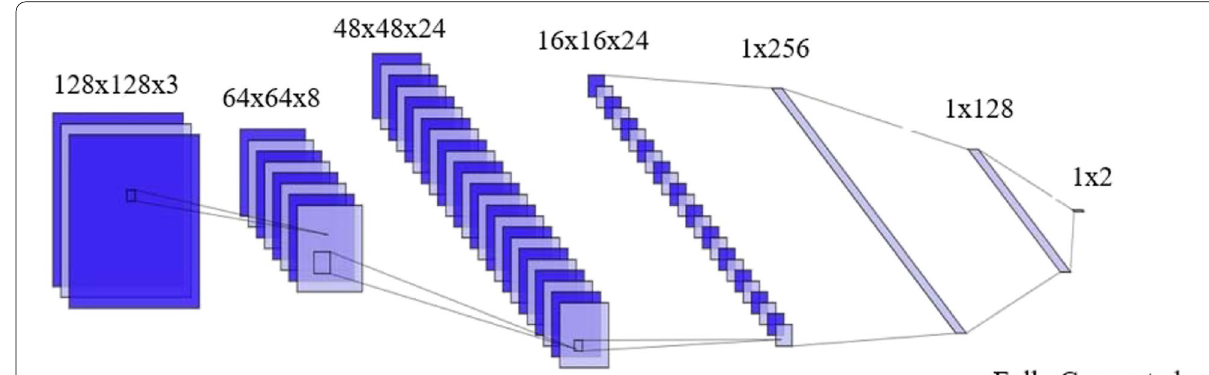
Fig. 2 An example of a typical CNN architecture